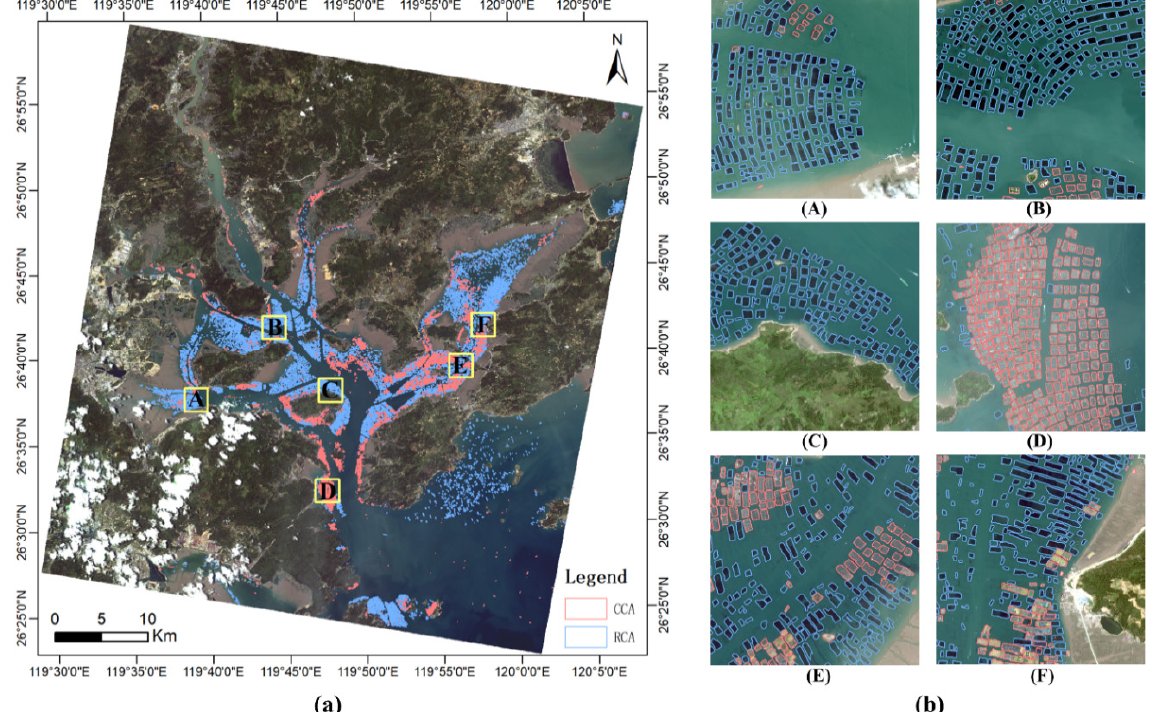
Figure 2. ( a ) Extraction results of aquaculture area in Sandu’ao; ( b ) extraction results of six aquacul- ture areas (A–F in ( a )), where the blue box represents raft culture area, and the red box represents cage culture area.